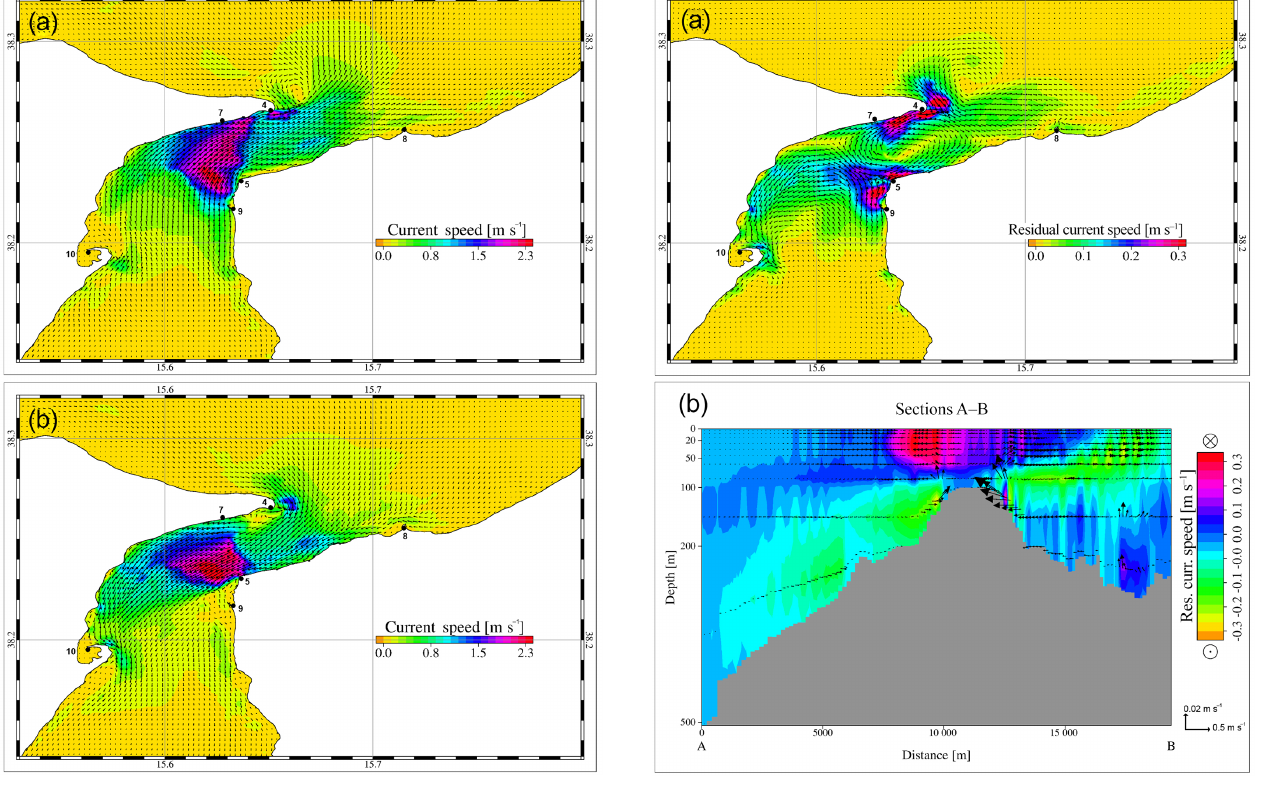
Figure 3. Vertically averaged residual circulation induced by tides in MS (a) and residual flow across (colour bar) and along (vectors) sections A–B (b)